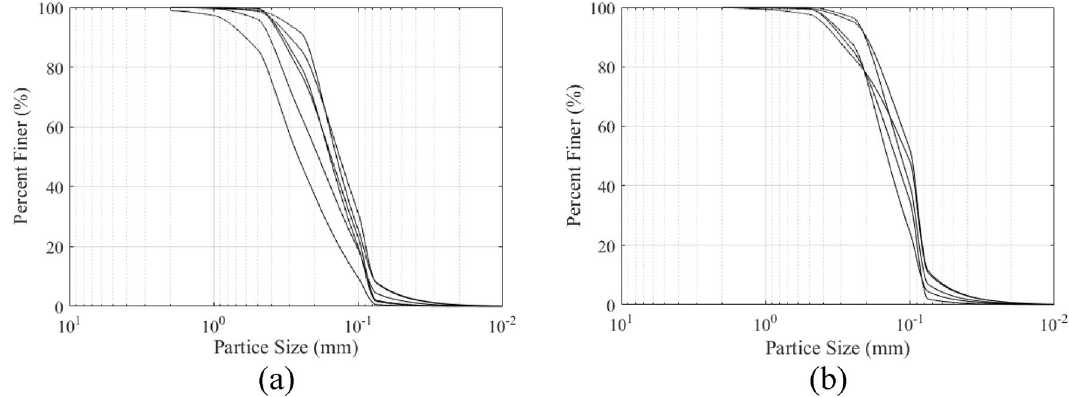
Figure 6. Particle size distribution of the two types liquefied sand ( a ) yellow fine sand ( b ) gray fine sand.